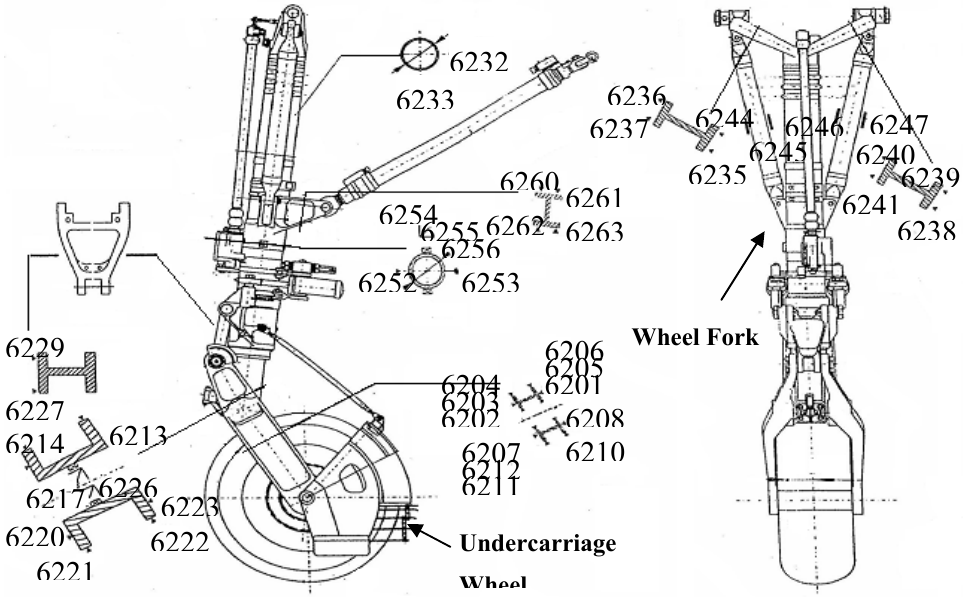
Figure 12. The real aircraft fore-undercarriage of a fighter plane and the strain gauges distribution.